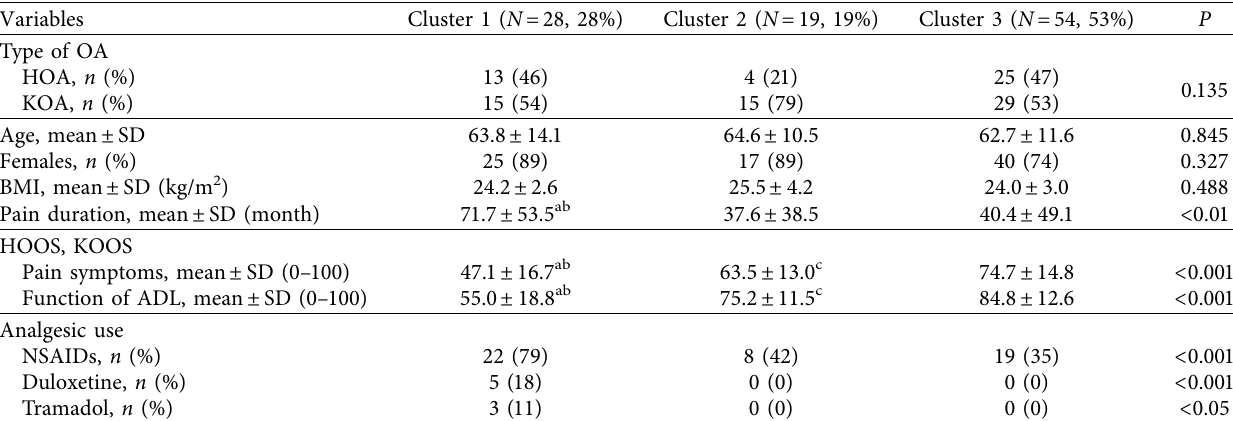
Figure 1: Participant flow through Table 1: Demographic data of each cluster.